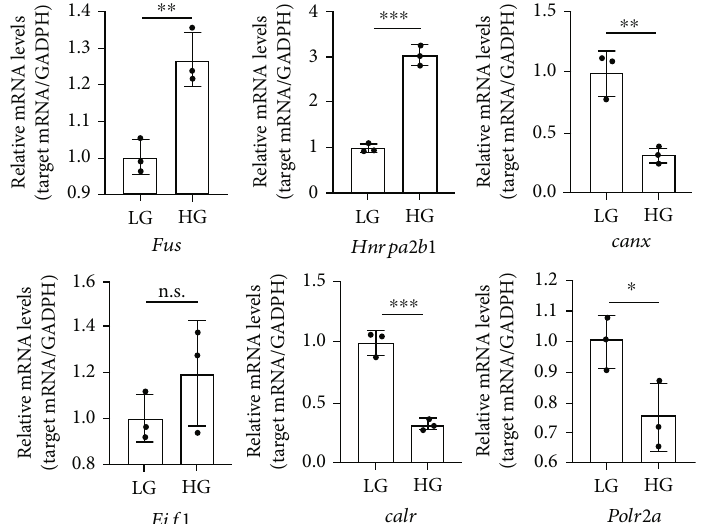
Figure 4: mRMVECs were exposed to hypoglycemia (5.5mM) or hyperglycemia (25 mM) for 48h. qRT-PCR was performed to detect di ff erentially expressed 6RBP genes. GAPDH was detected as the internal control. Data are expressed as mean ± SD ( n = 3 , from separate cell samples). ∗ p < 0 : 05 , ∗∗ p < 0 : 01 , and ∗∗∗ p < 0 : 001 , n.s.: not signi fi cant, by 2-tailed Student ’ s t